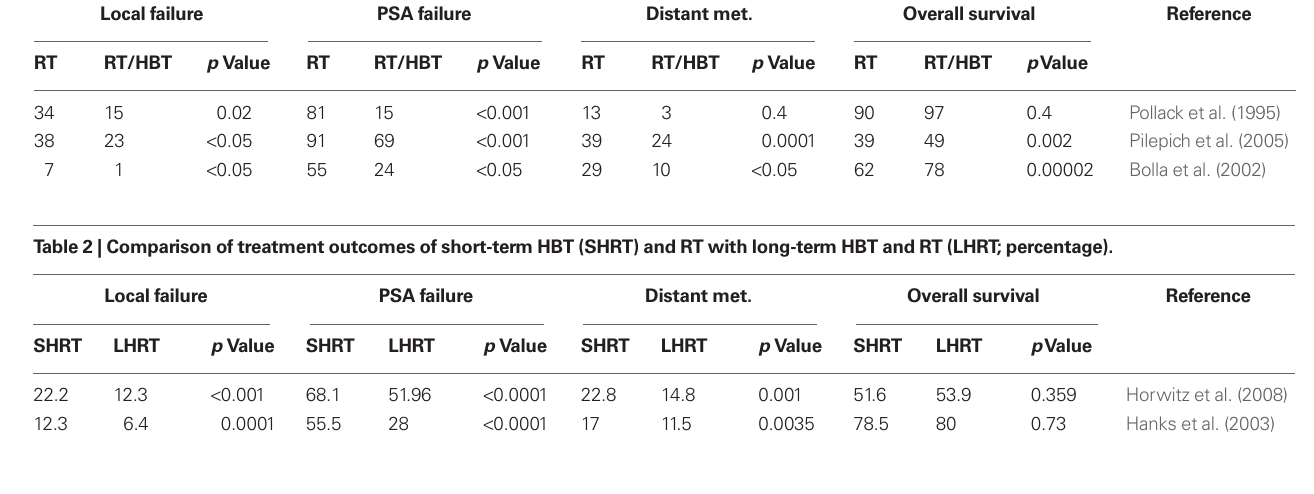
Table 1 | Comparison of treatment outcome of RT vs RT/HBT (percentage). Local failure PSA failure Distant met.